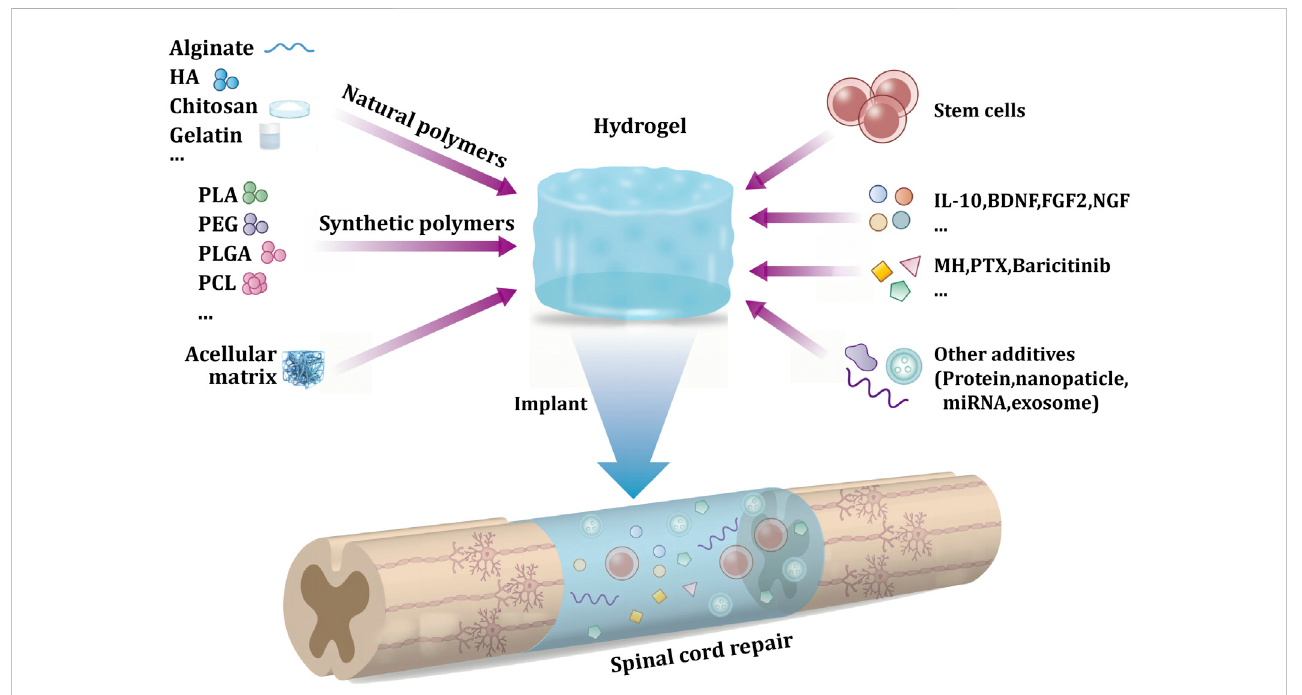
FIGURE 1 Schematic diagram of hydrogel delivery system in secondary spinal cord injury implantation